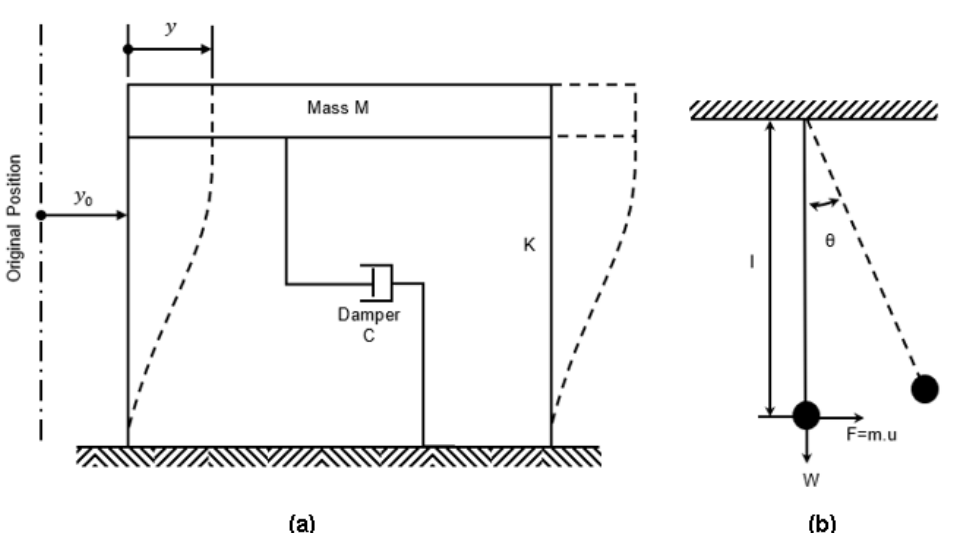
Figure 4. Two linear and nonlinear dynamic systems utilized in the study: ( a ) single degree of freedom structure subjected to a later loading. Source: adapted from Carmichael [21]. ( b ) A schematic diagram of a simple pendulum.